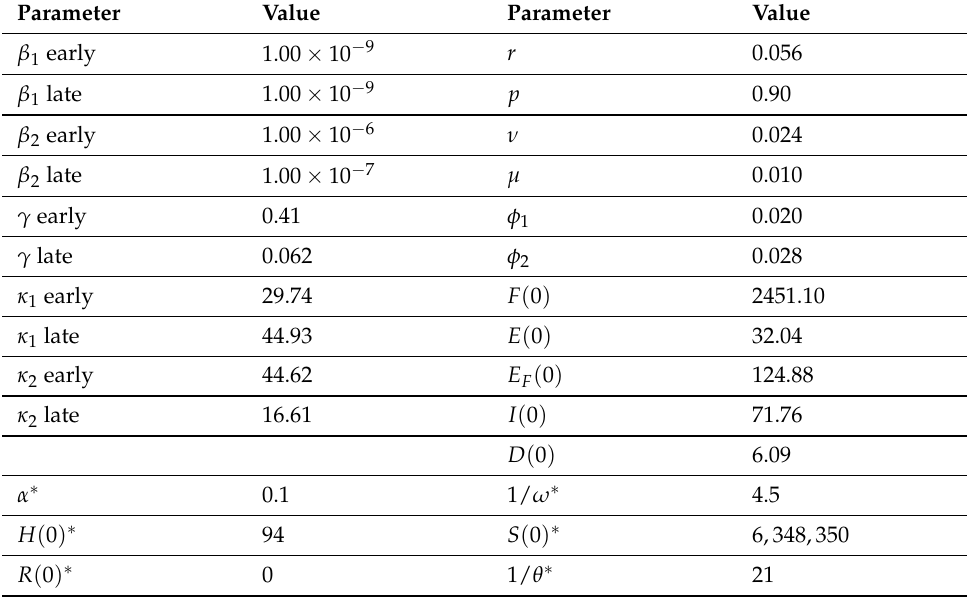
Figure 3. Dynamics of class F in the upper left, class E F in the upper right, their sum on the bottom left, and the integral of those leaving E F to be hospitalized on the bottom right. These classes correspond to the parameters from Table 2 and the data simulations from Figure 2. Table 2. Values for parameters, with five parameters having early and late values. Parameters with ∗ were taken from the data or the literature. Others were